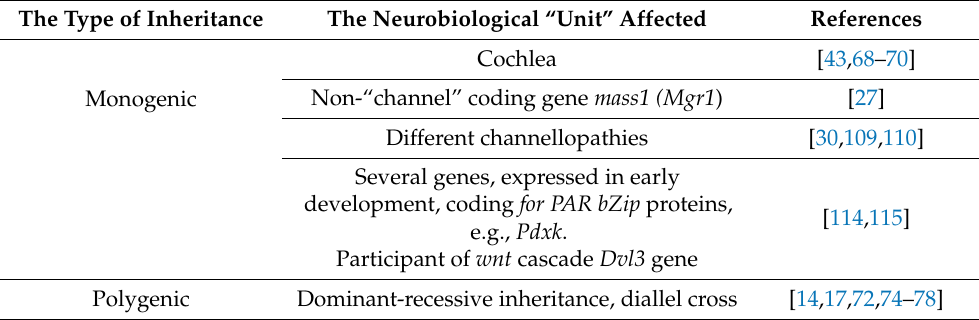
Table 2. The genetic data on AE susceptibility